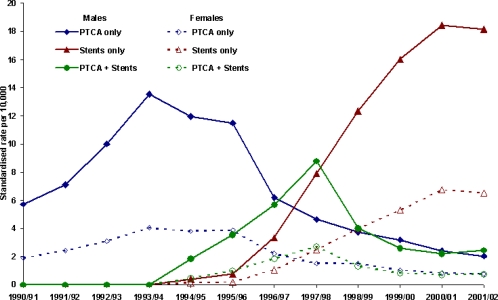
Age standardised PCI rates by type of procedure and sex, 1990–91 to 2001–02 (PCI rates per 10,000 NSW resident population aged 30+ in December 2001 as the standard).